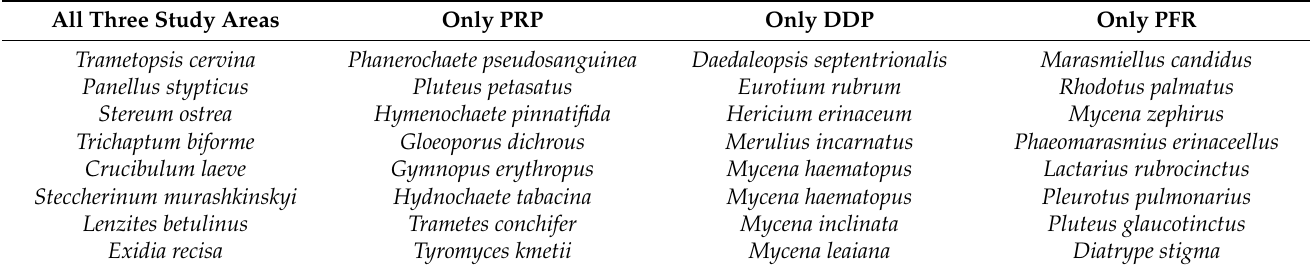
Table 4. Distribution of wood-decay fungi in the three different study areas.